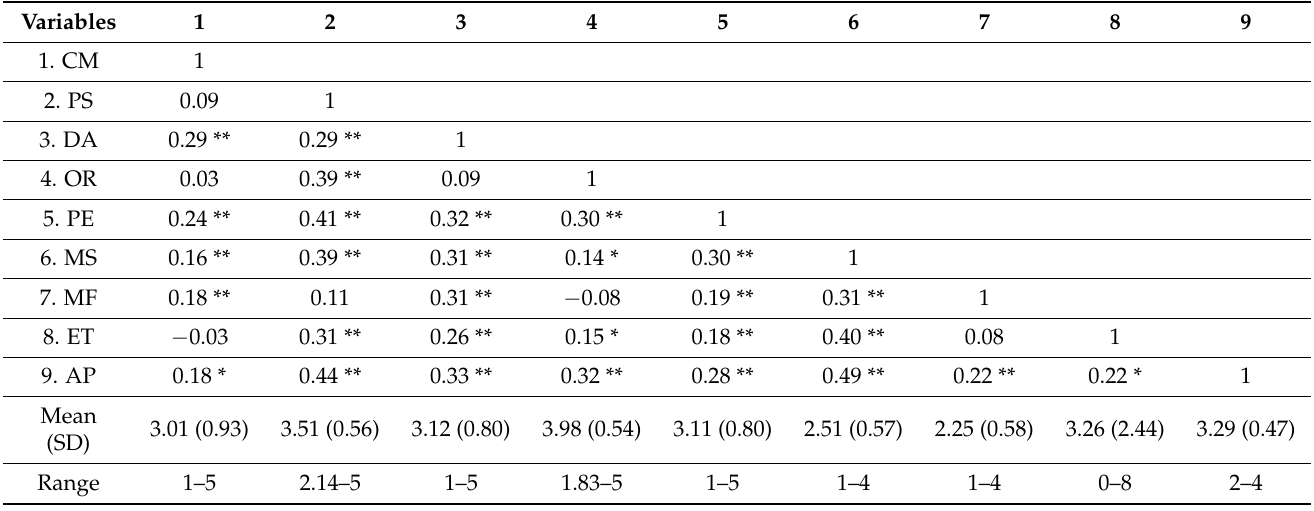
Table 2. Means, standard deviations, ranges, and inter-correlations of the study variables ( n = 243).